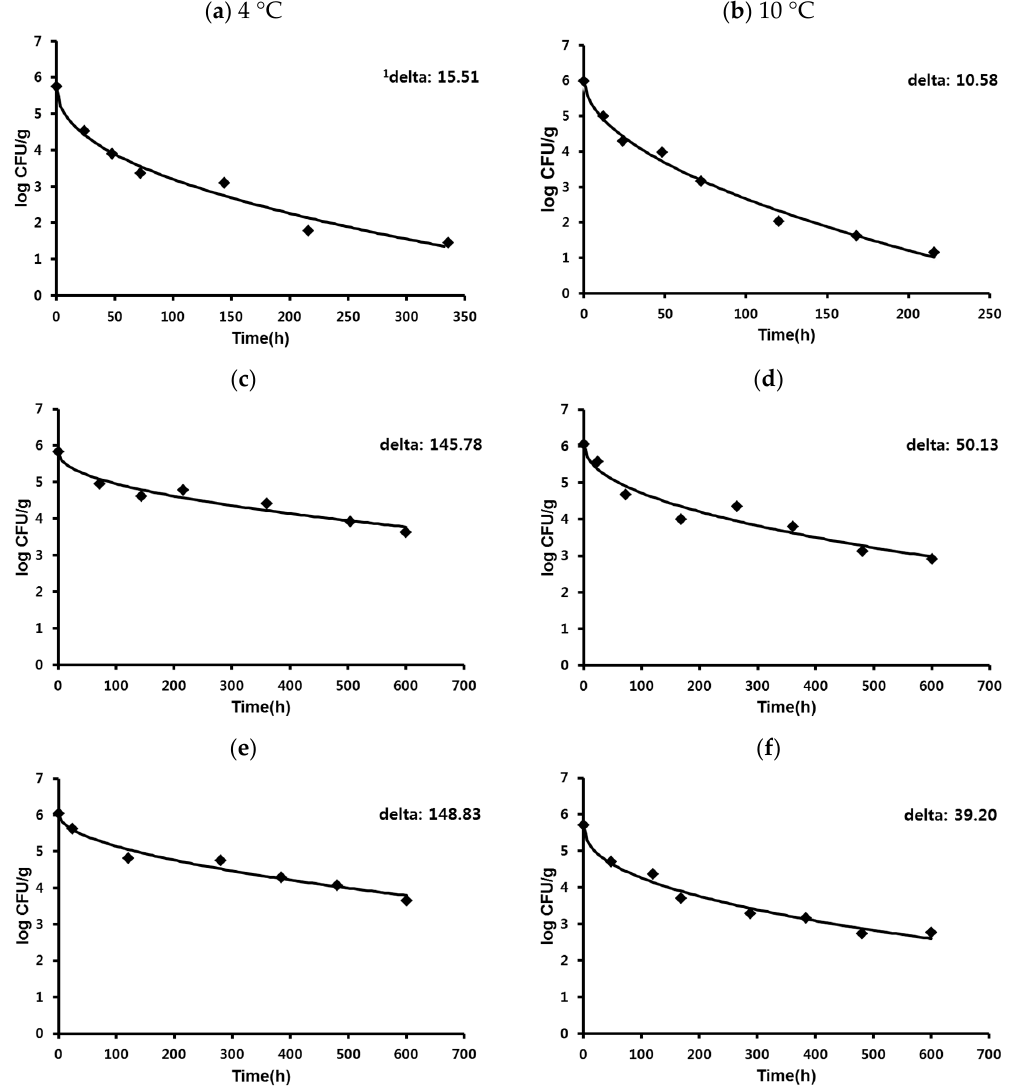
Figure 1. Primary survival models of C. jejuni on various processed meat products. ( a ) dry-cured ham at 4 °C; ( b ) dry-cured ham at 10 °C; ( c ) round ham with sodium nitrite at 4 °C; ( d ) round ham with sodium nitrite at 10 °C; ( e ) sausage without sodium nitrite at 4 °C; and ( f ) sausage without sodium nitrite at 10 °C. 1 Delta: treatment time for the first decimal reduction.